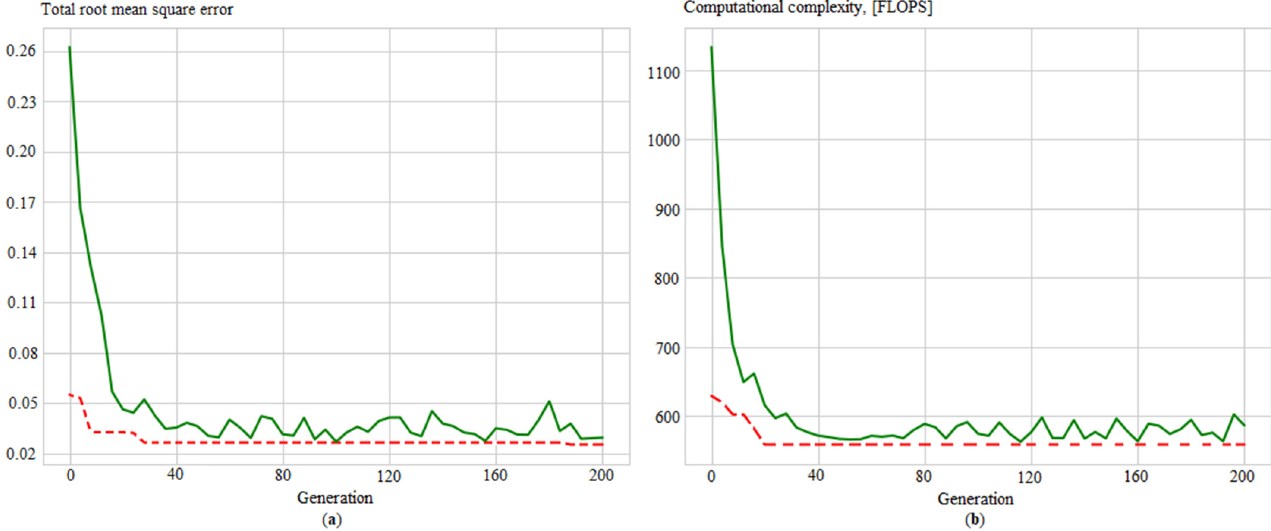
Figure 12. Evolution of the ANN ident in the process of determining its best structure by: ( a ) total root mean square error and ( b ) computational complexity, where solid green lines are average values per generation, and dotted red lines are minimum values per generation.